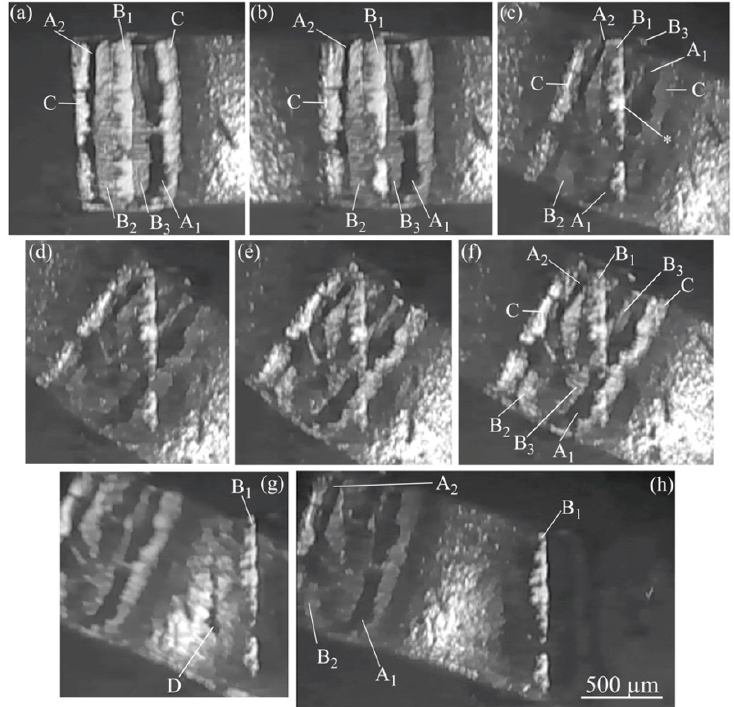
Figure 11. Twist and peel test of ultrasonic bonded interface between Al ribbon and silica substrate ( F b = 7 N and P u = 4 W): ( a ) Before twisting; ( b ) Immediately after twisting Al ribbon (start time of stage 1); ( c ) When twisting Al ribbon by 25° in clockwise direction; ( d ) Twisting by 40° when step 1 is complete; ( e ) At the beginning of step 2 in counterclockwise direction; ( f ) Twisting by ~18° in step 2; ( g ) Immediately after fracture occurs due to peeling (step 3); ( h ) After fracture. Mark D and Area B 1 remain on silica side.